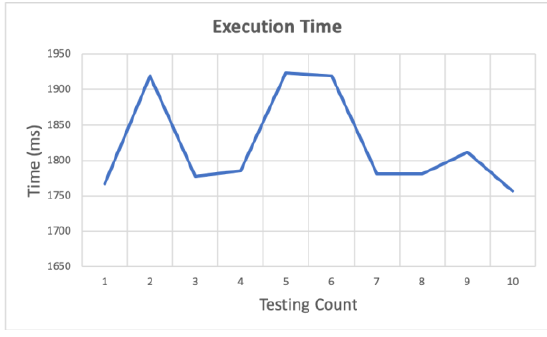
Figure 12. Execution time of Algorithm 2 by Python on PI 3.